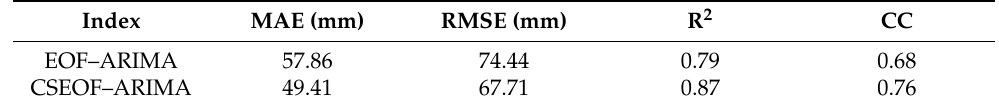
Table 1. Quantitative statistical verification measures of forecasts.